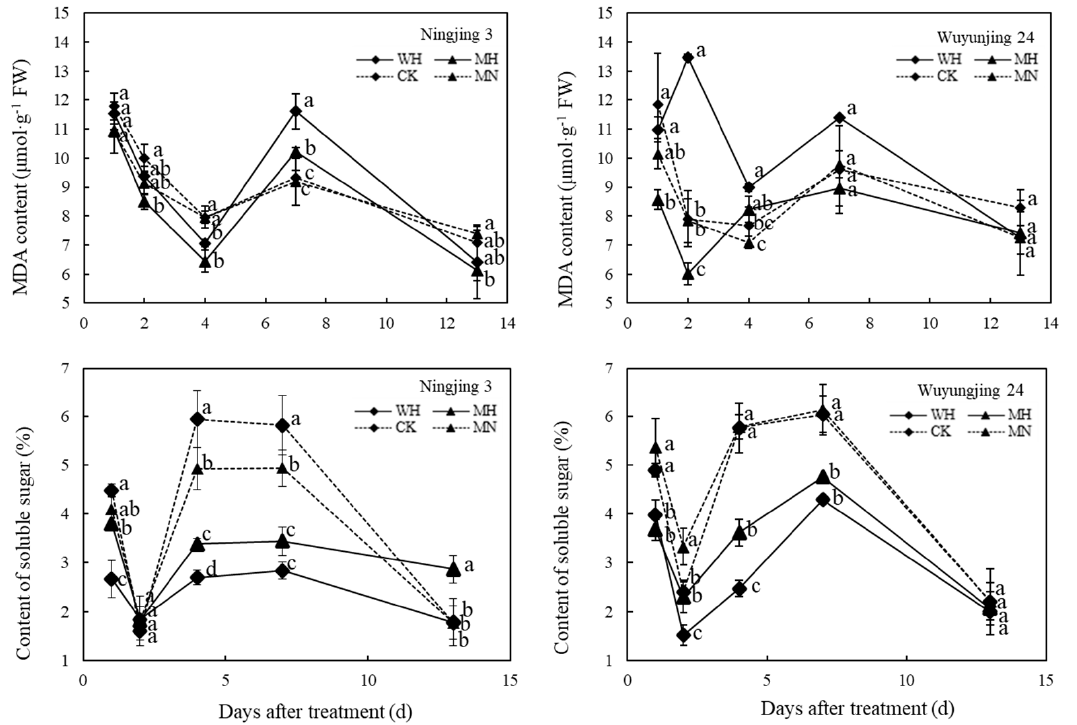
Figure 4. Effects of exogenous MeJA on the content of MDA and soluble sugar of rice leaves at the booting stage under high temperatures. Note: CK: natural temperature and sprayed with water; MN: natural temperature and sprayed with MeJA; WH: heat stress and sprayed with water; MH: high temperature and sprayed with MeJA. MDA: malondialdehyde. Bars are the standard deviation. Values followed by different letters are significantly different at the 5% probability Level.